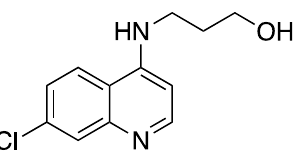
Figure 8. Structure of 3-(7-Dichloroquinolin-4-ylamino)propanol.